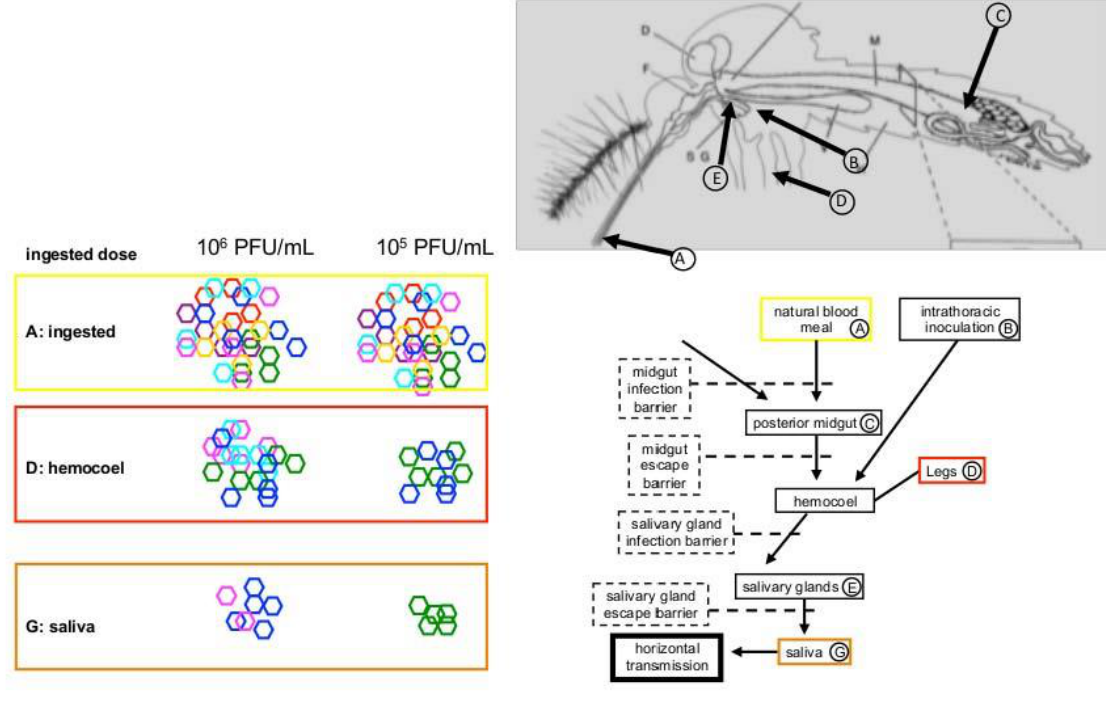
Figure 2. Changes in Venezuelan equine encephalitis virus populations after anatomical bottlenecks in Culex taeniopus mosquitoes fed mixtures of eight barcoded virus variants colored circles). Variant diversity decreased at dissemination and in saliva and the number of variants transmitted in saliva was lower in mosquitoes that ingested lower viral